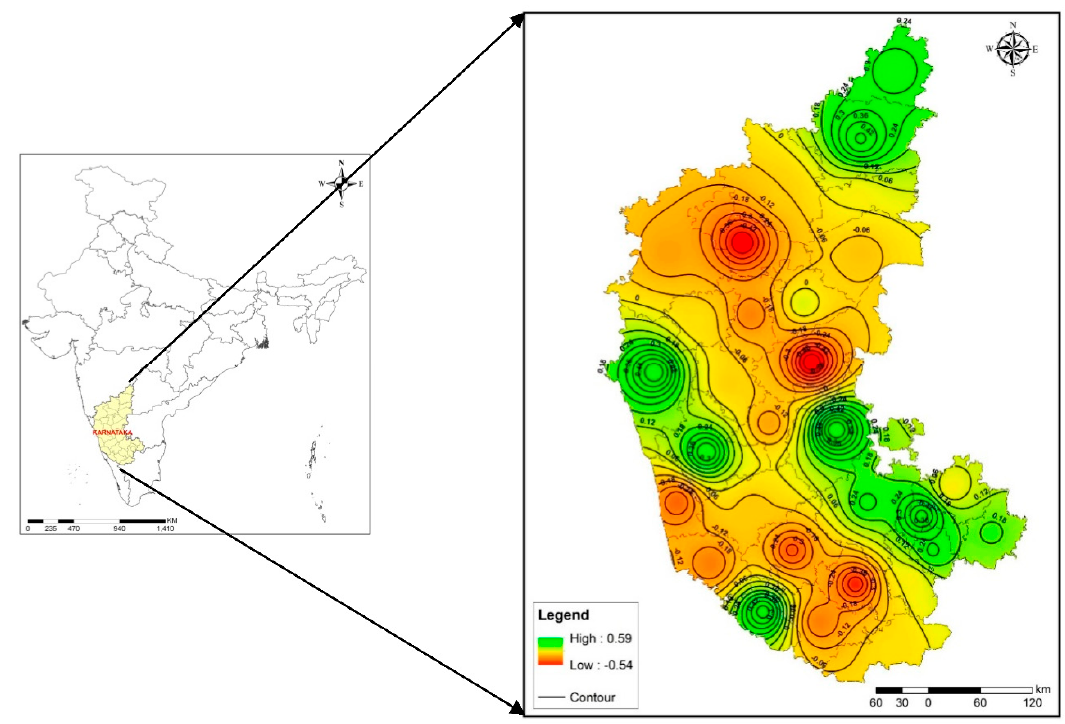
Figure 6. District ‐ wise correlation coefficient of Kharif rice yield with S ‐ W monsoon rainfall for Karnataka. Figure 6. District-wise correlation coefficient of Kharif rice yield with S-W monsoon rainfall for